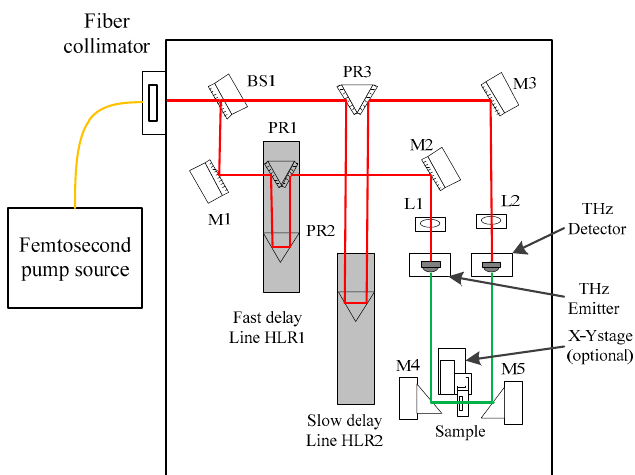
Figure 1. Optical path of terahertz time-domain spectroscopy system.